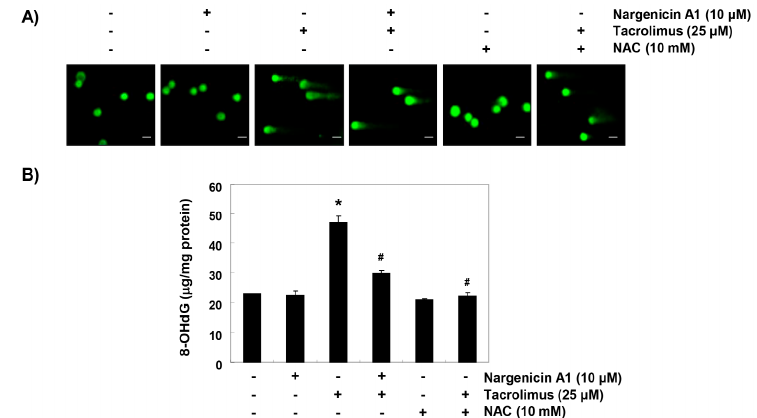
Figure 3. Protection effect of nargenicin A1 on tacrolimus-induced DNA damage in HINAE cells. ( A ) Cells were pretreated with 10 µ M nargenicin A1 or 10 mM NAC for 1 h, and then stimulated with or without 25 µ M tacrolimus for 24 h. Comet assays were used to detect DNA damage. The representative images shown were taken using a fluorescence microscope (original magnification, × 200). Scale bar, 20 µ m. ( B ) Cellular DNA was isolated from cells grown under the same conditions and quantified using a spectrophotometer. Amounts of 8-OHdG in DNA were determined using an 8-OHdG-EIA kit. Results are presented as the means ± SD of triplicate measurements (* p < 0.05 versus non-treated controls, # p < 0.05 versus tacrolimus treated cells).